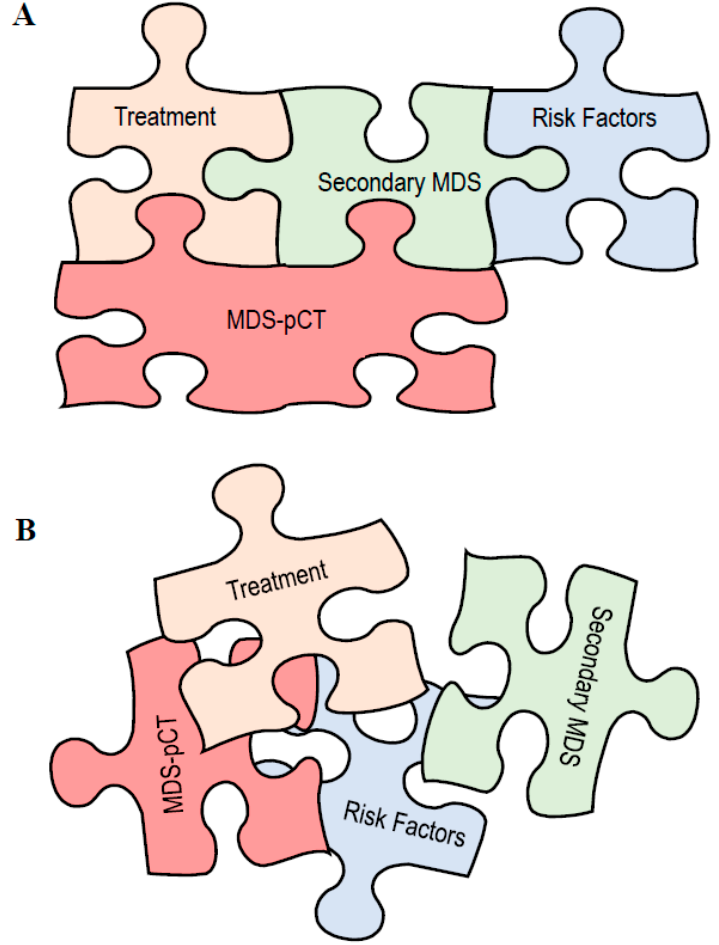
Figure 1. Secondary myelodysplastic neoplasm (MDS) jigsaw pieces. ( A ) Current classifications based on delimited etiologies for secondary MDS arising from cytotoxic treatment or risk factors (genetic predisposition and clonal hematopoiesis of indeterminate potential, CHIP). MDS post-cytotoxic therapy (MDS-pCT) or therapy-related myeloid neoplasm (TRMN) were secondary MDSs arising from treatment effects with no overlap with other risk factors. ( B ) New classification approach. Both cytotoxic treatment and the presence of an underlying germline or CHIP conditions are overlapping etiologies and compose different susceptibility scenarios. The different contribution of several